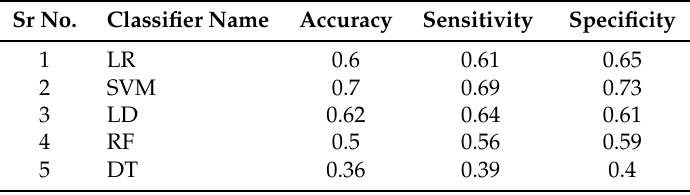
Table 8. 10-Fold Results based on the Top 1500 Selected Features based on Proposed 3-Stage Approach. Sr No.